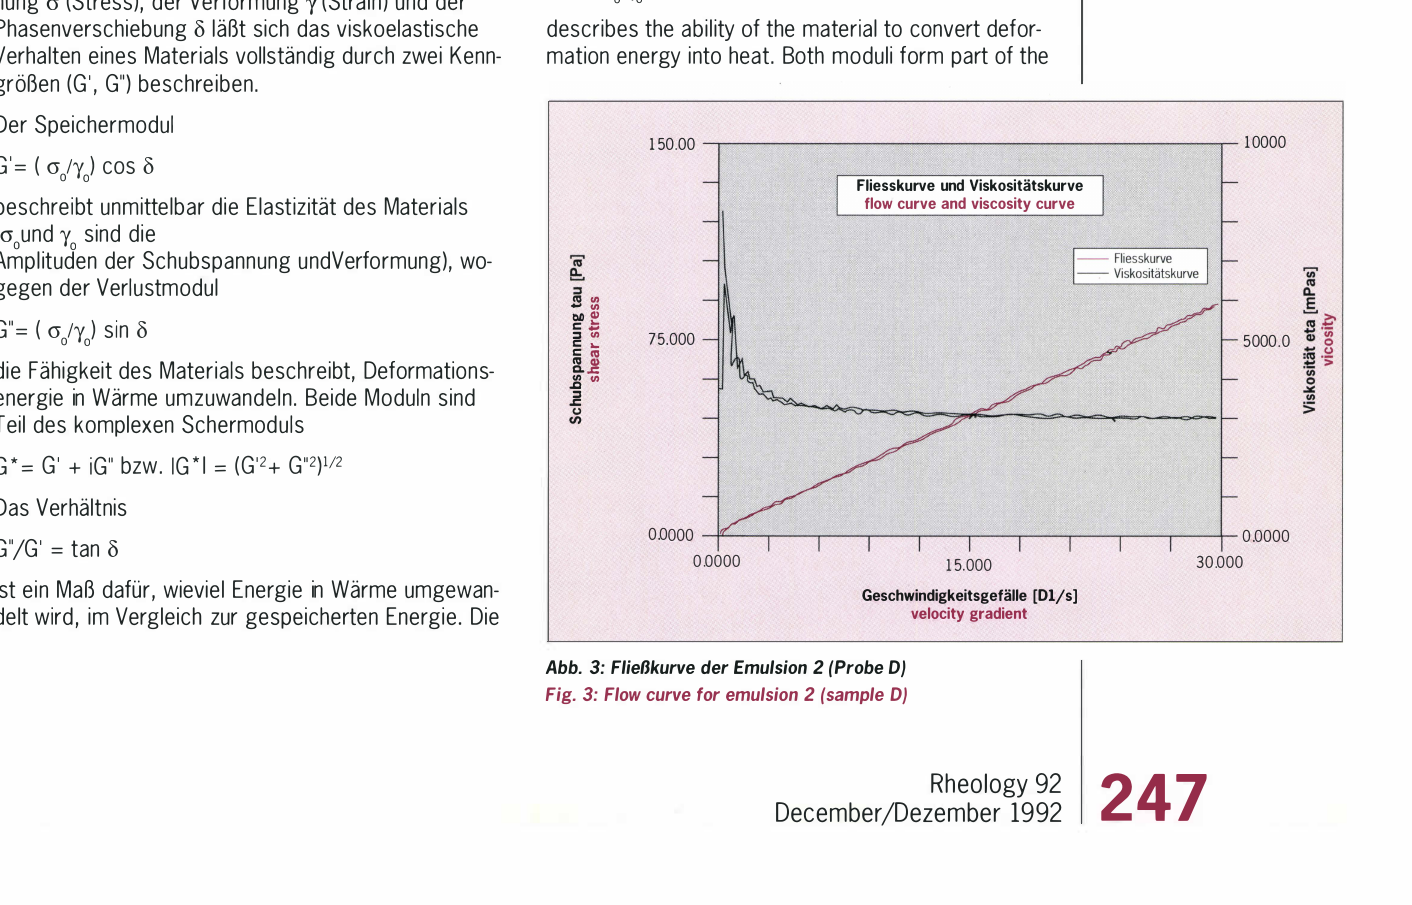
Flow curve for emulsion 1 (sample B) Fliesskurve und Viskositatskurve flow curve and viscosity curve of the coaxial measuring system -but the outer cyl­ inder oscillates with a very small amplitude at a given 10000 frequency. This causes periodic deformation of the sample and the resultant periodic force is measured using a torque sensor. For a viscoelastic material, (shear) force and (shear) deformation are not in formation at maximum force -but deformation comes later than force (phase displacement). From a knowledge of force and shear stress cr , deformation y (strain) and phase dis­ placement 8, it is possible to completely describe the G' and G". The storage modulus G'= ( <JiYo) cos 8